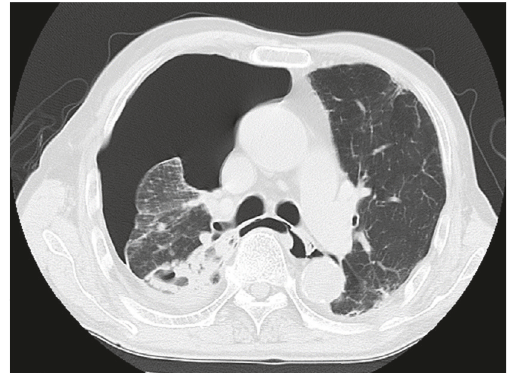
Figure 1: Chest computed tomography scan shows pneumothorax and pleural effusion in the right pleural cavity and a cavity lesion in the right upper lobe.